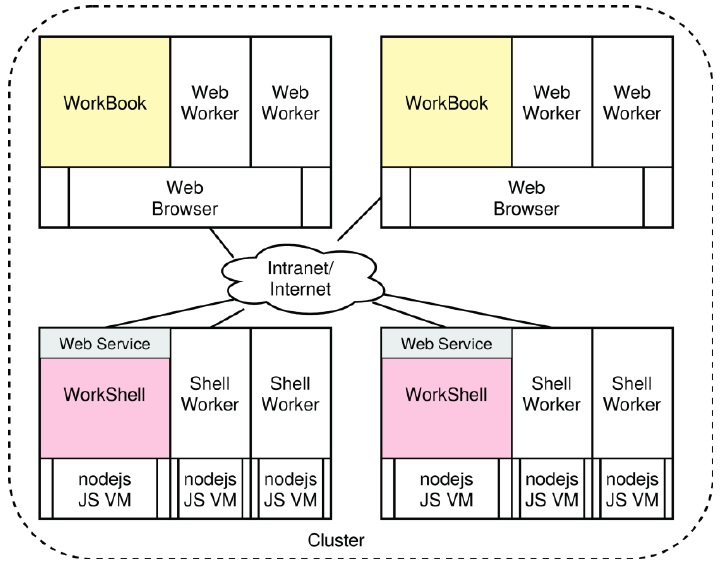
Figure 2. The cluster approach: heterogeneous processing architecture with web browsers (WorkBook) and node.js (WorkShell), connected via the intra- and internet. Parallel execution is provided by spawned WebWorker and